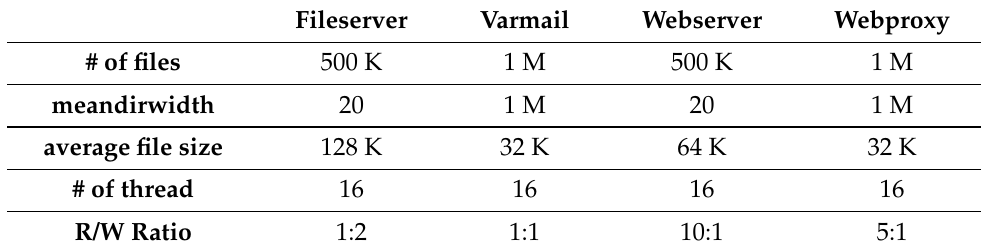
Table 2. Filebench workload